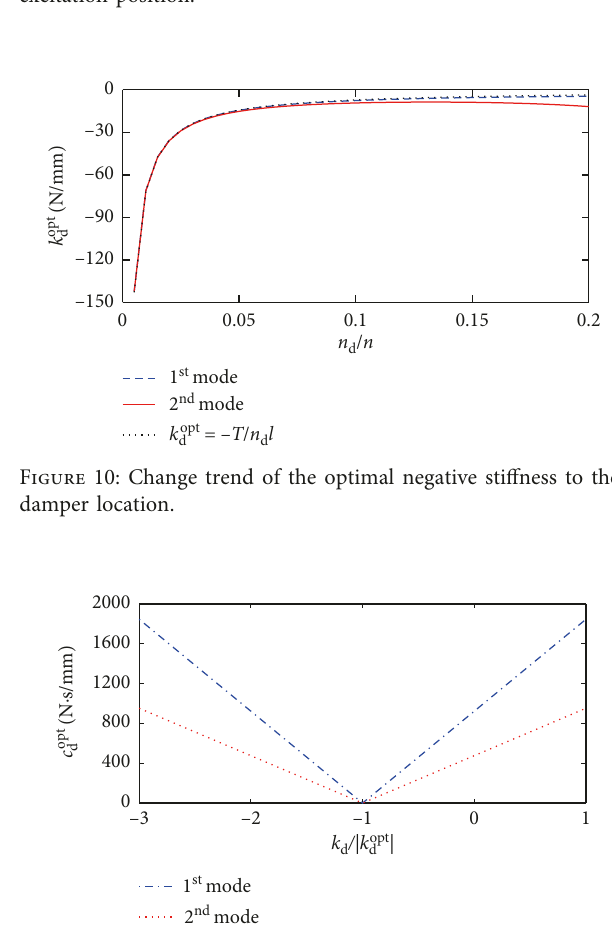
Figure 11: Optimal damping corresponding to the negative stiffness.